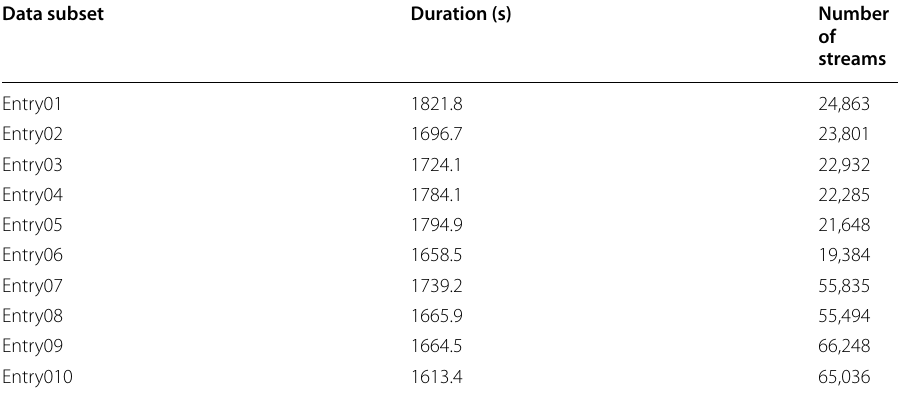
Table 1 Dataset characteristics Data